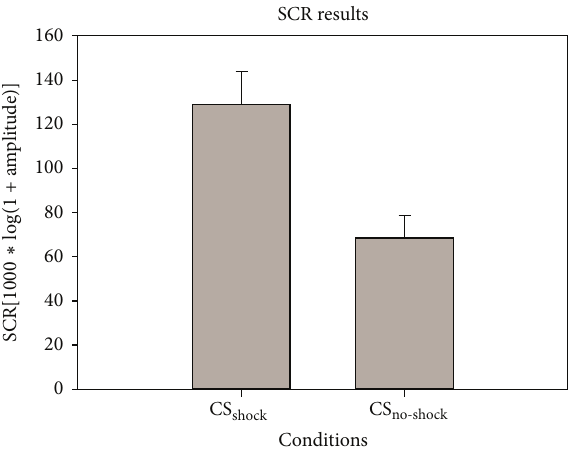
Figure 3: SCR results. 𝑥 -axis indicates independent variables: versus CS . 𝑦 -axis reflects the mean amplitudes of SCR CS shock no-shock calculated from all subjects (mean ± S.E.). The average SCR of waslargerthanthatofCS duringthemovieprojection. CS shock no-shock